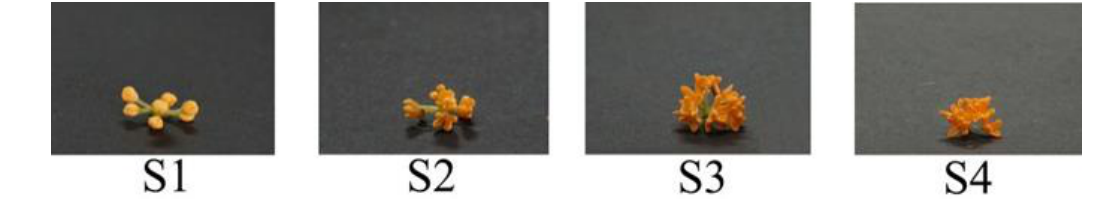
Figure 3. Flowering stages of ‘Yanhonggui’.